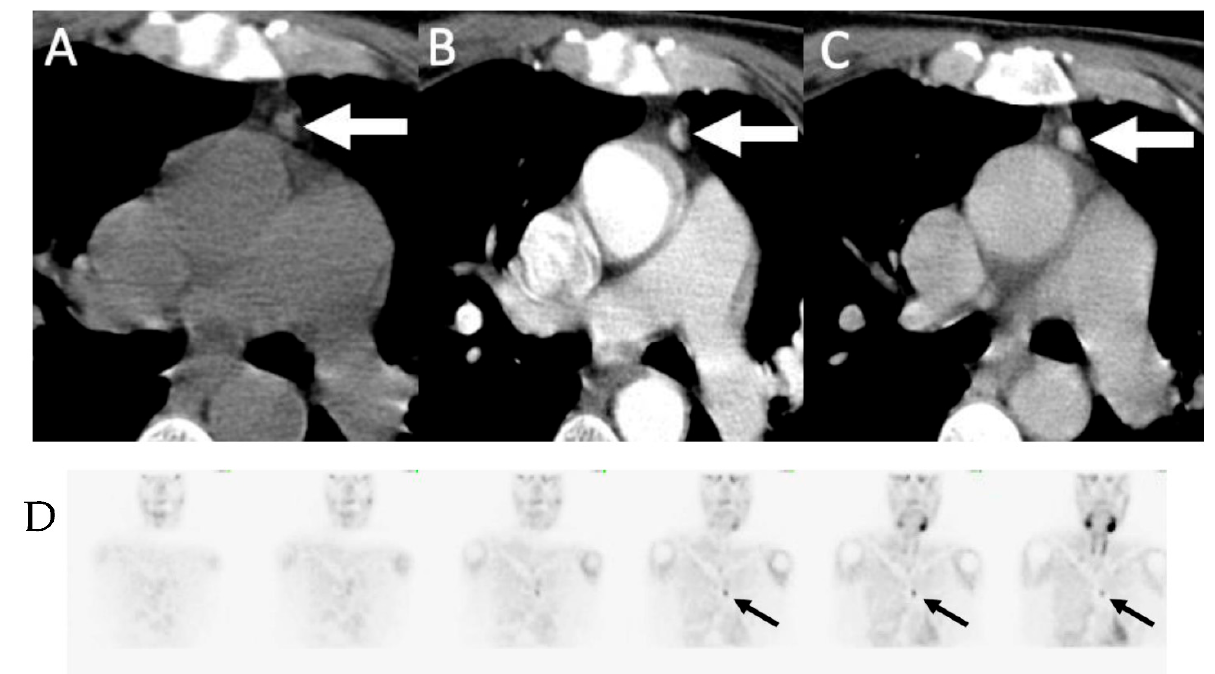
Figure 5. Ectopic mediastinal adenoma: 62-year-old man with primary hyperparathyroidism 4D-CT demonstrating a small enhancing nodule in the anterior mediastinum (arrows) seen on non-contrast ( A ), arterial-phase ( B ) and delayed phase ( C ) imaging without washout. ( D ) Coronal early phase sestamibi SPECT images demonstrate mild uptake in the anterior mediastinum, corresponding to the enhancing nodule on 4D-CT. The patient was subsequently taken for thoracoscopic resection which demonstrated an ectopic parathyroid adenoma within thymic tissue.